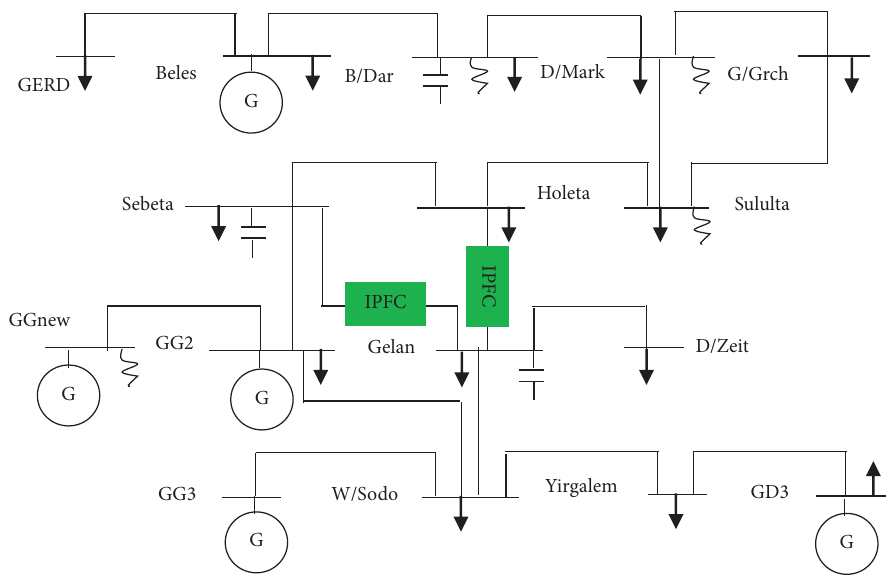
Figure 2: Proposed power system with IPFC. Table 9: BVSI during an outage of Sebeta to the Holeta branch with IPFC.